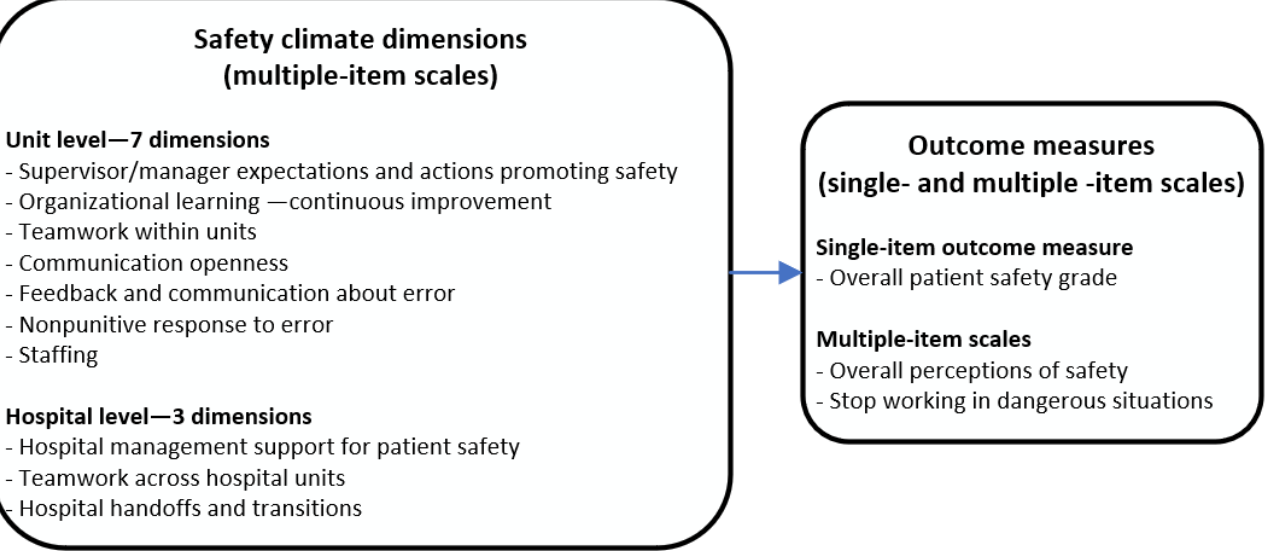
Figure 1. Measurement concepts included in HSOPSC.